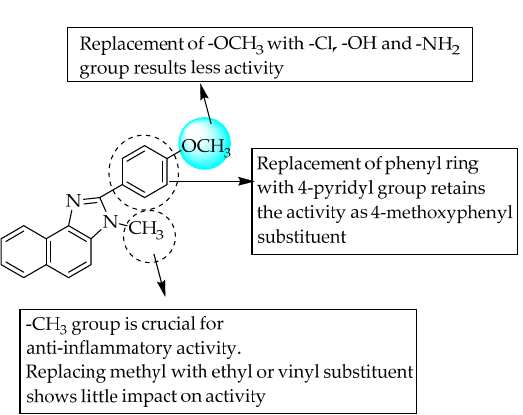
Figure 39 . SARs of 1,2-substituted naphthimidazoles.